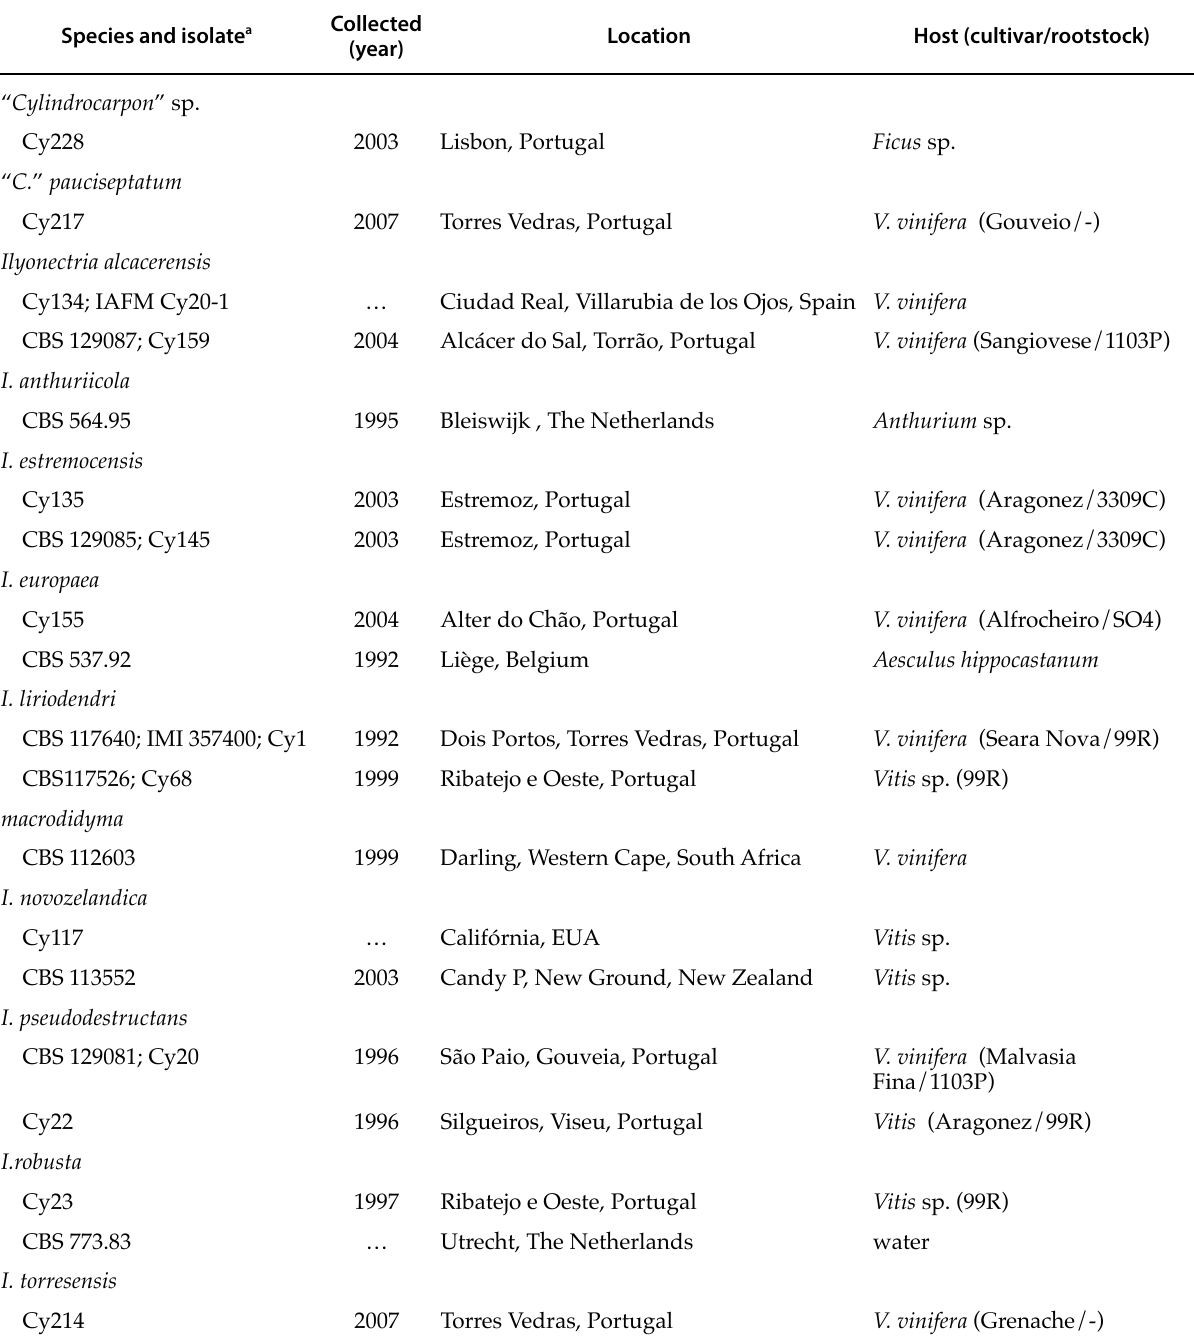
Table 2. Details of Ilyonectria spp . and “ Cylindrocarpon ” spp . isolates used in phylogenetic studies. Collected Location Host Species and isolate a (year)